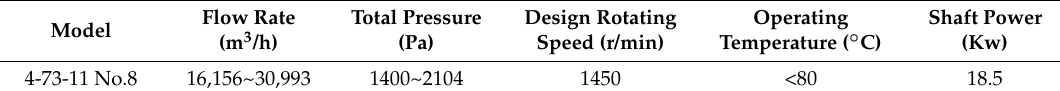
Table 2. Parameters of Finite Element (FE) calculation centrifugal fan model.